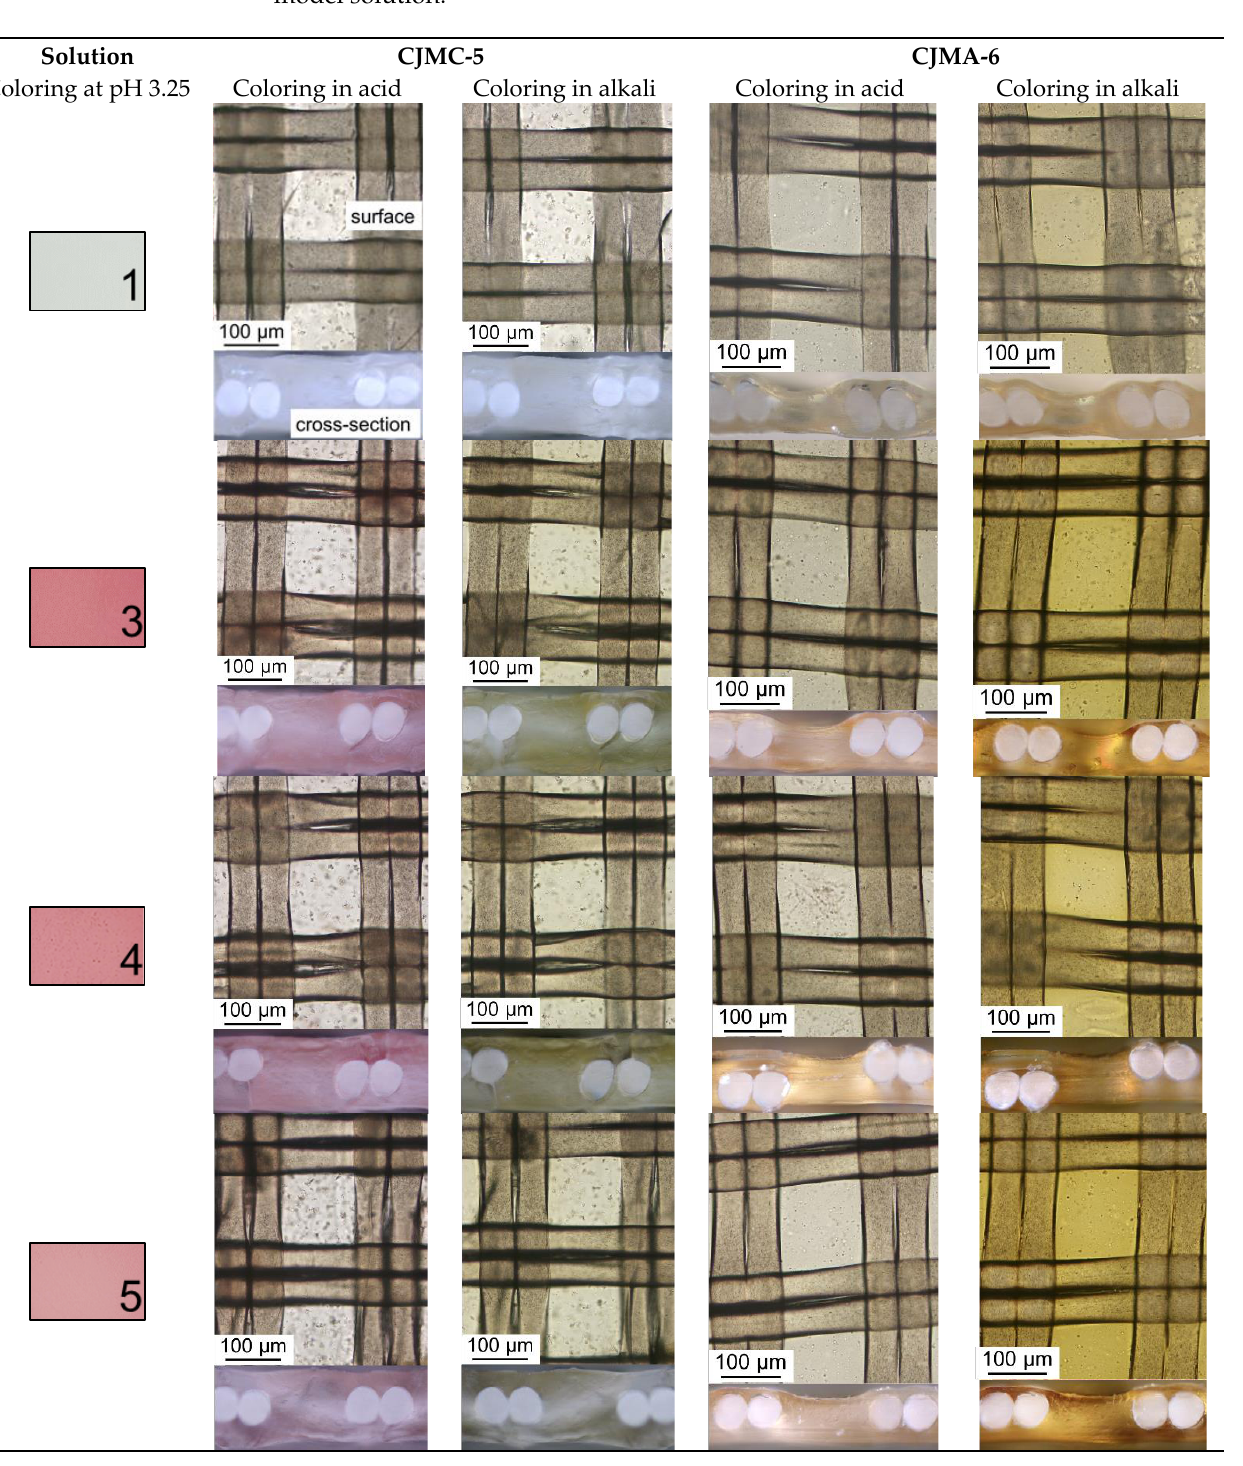
Figure 6. Optical images of the surface and cross-sections of CJMC-5 and CJMA-6 membranes after soaking in model solutions without applying an electric field ( i = 0 mA/cm 2 ). The numbers correspond to the designation of the model solutions in Table 2.